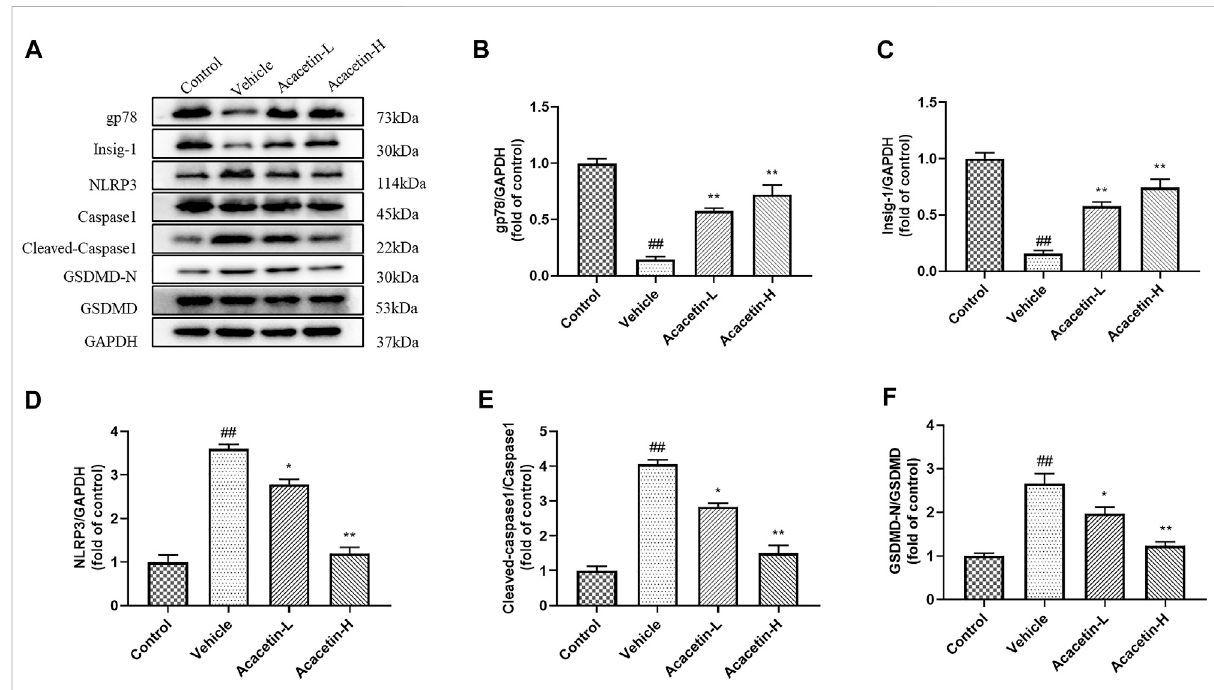
FIGURE 4 Effect of acacetin on gp78-mediated NLRP3 in fl ammasome in the hippocampus. (A) Representative western blots of gp78, Insig-1, NLRP3, Caspase1, cleaved Caspase1, GSDMD-N, and GSDMD. (B – F) Quantitative analysis of western blot results. Results are expressed as the mean ± SEM ( n = 3 per group). ## p < 0.01 vs. Control; * p < 0.05, ** p < 0.01 vs.